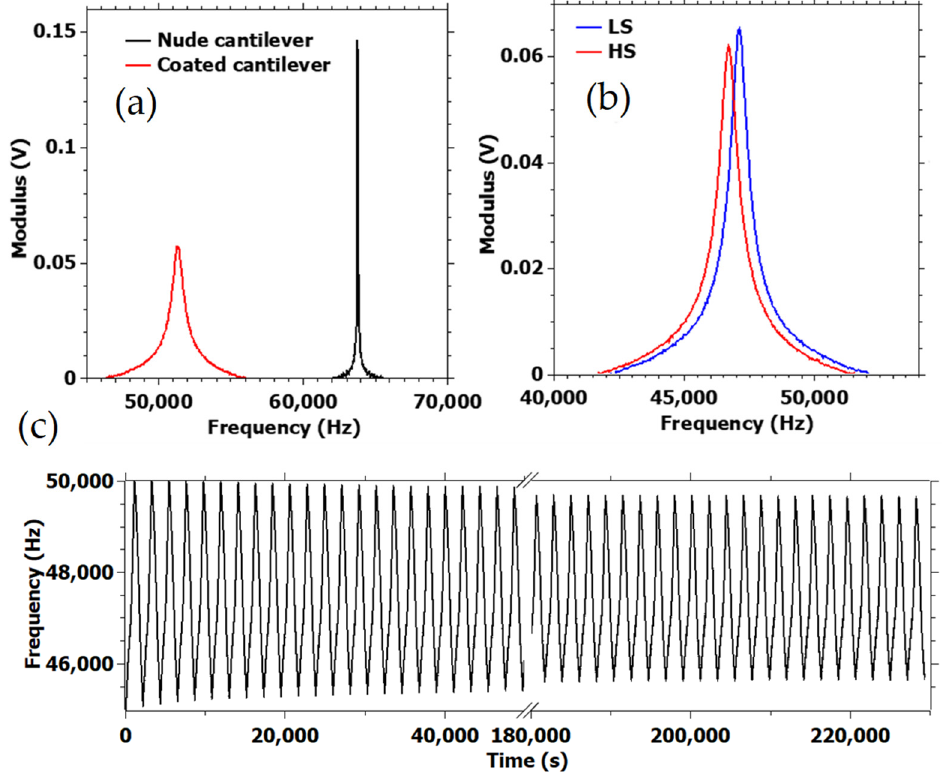
Figure 2. ( a ) Resonance peak of a cantilever before and after coating with a 1.5 µm-thick [Fe(Htrz) 2 (trz)](BF 4 )@P(VDF-TrFE) composite film (T = 25 °C). ( b ) Resonance peak of the coated cantilever acquired in the LS and HS states within the hysteresis region (T = 90 °C). ( c ) Dynamic tracking of the MEMS resonance frequency for the coated cantilever upon 105 successive thermal cycles between 40–130 °C.